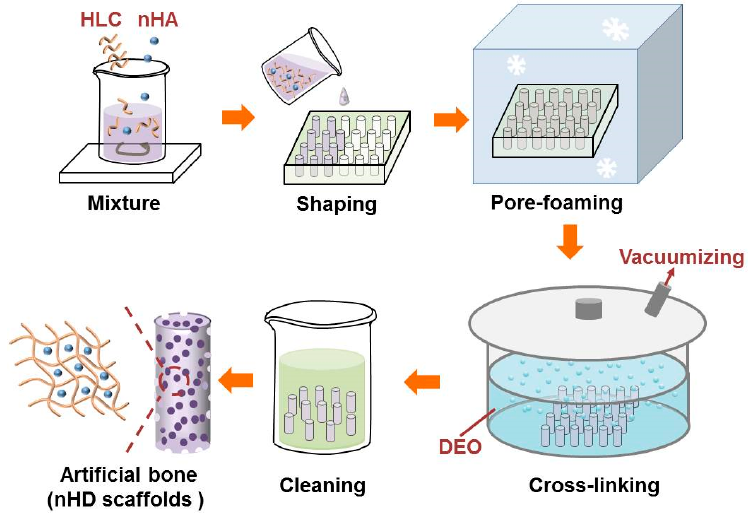
Figure 1. Schematic diagram of the synthesis of nano-hydroxyapatite (n-HA)/human-like collagen (HLC)/DEO (nHD) scaffolds.